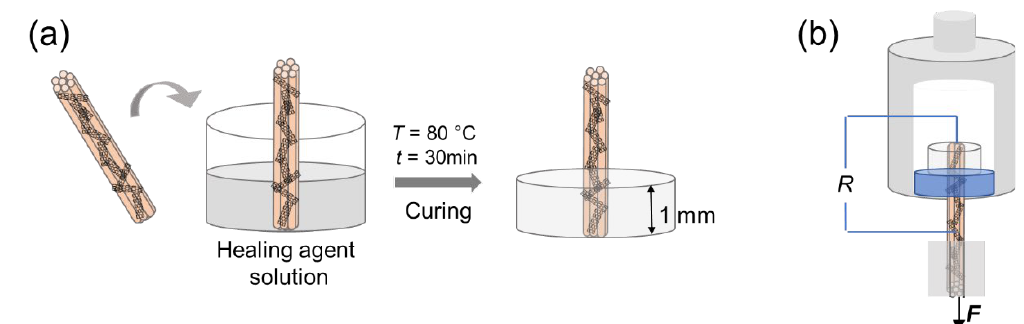
Figure 2. Schematics of ( a ) sample fabrication and ( b ) single-fiber pull-out test.